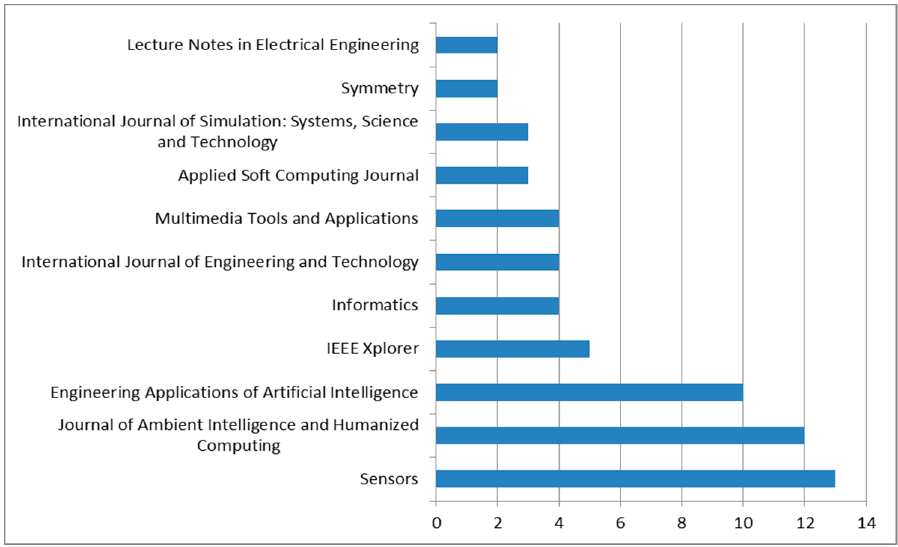
Figure 11. Distribution of articles according to the journal in which they were published.